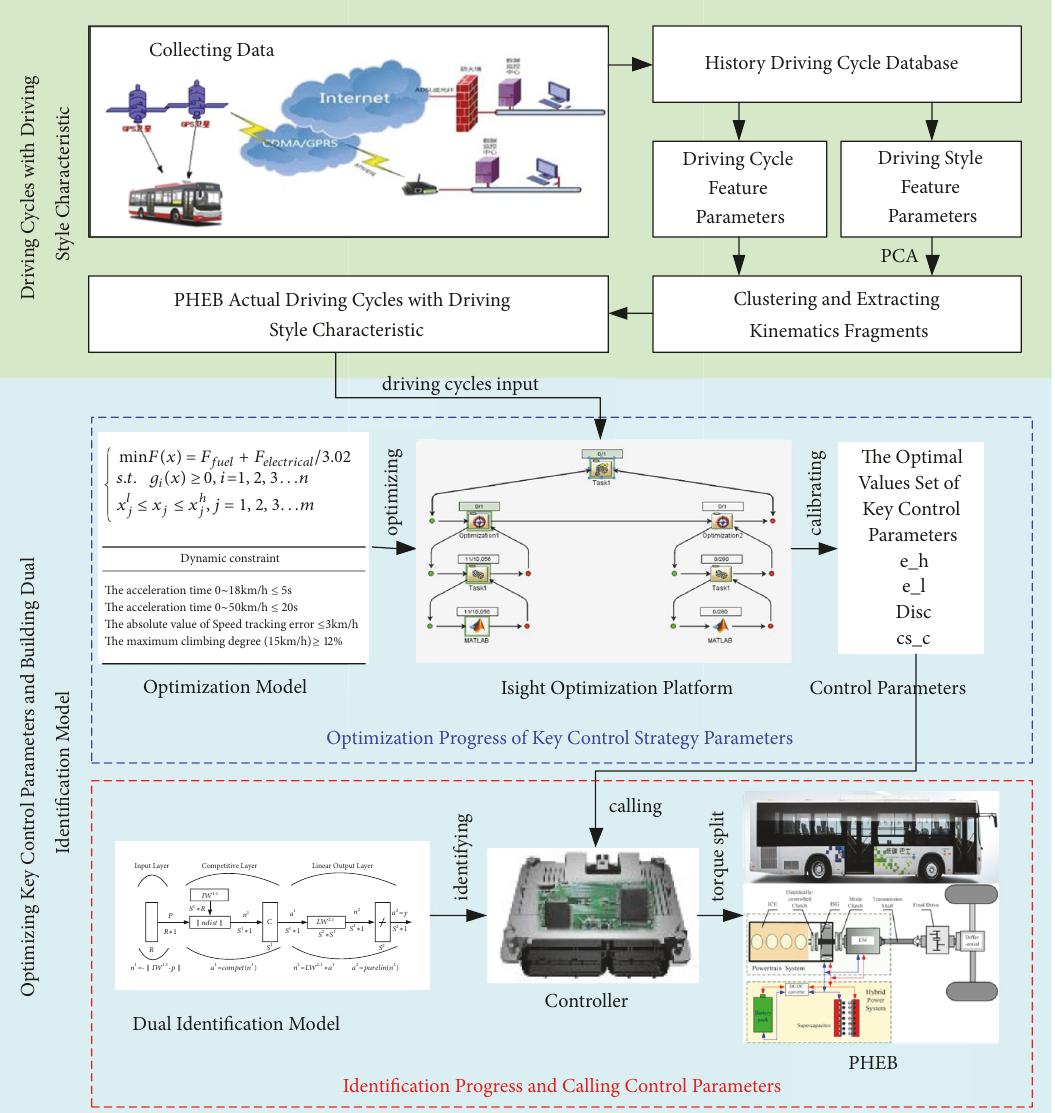
Figure 1: Structure schematic of this